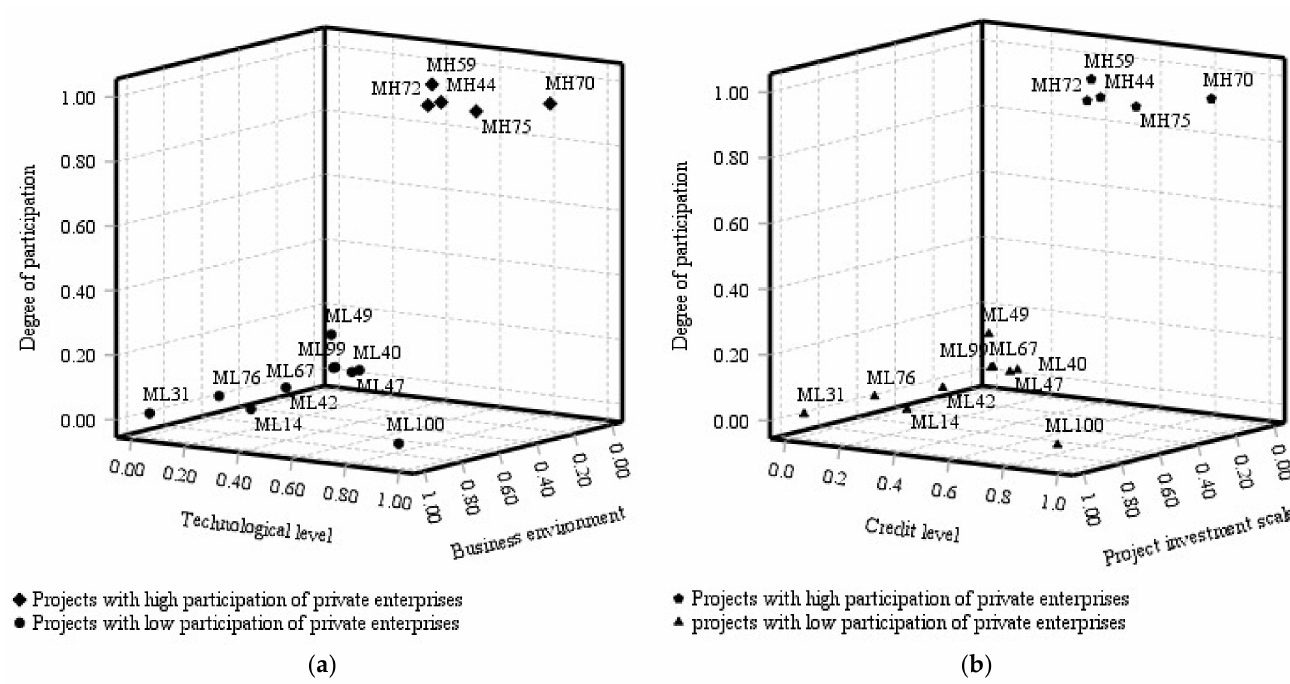
Figure 2. Comparison of the core conditions of projects with high or low participation of private enterprises. ( a ) Comparing the technological level and business environment of projects with high or low participation of private enterprises; ( b ) Comparing the credit level and project investment scale of projects with high or low participation of private